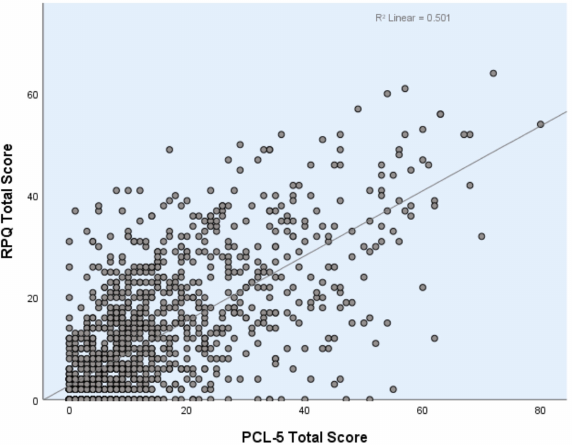
Figure A3. Regression line graph of RPQ total scores and PCL-5 total scores. RPQ: Rivermead Post-